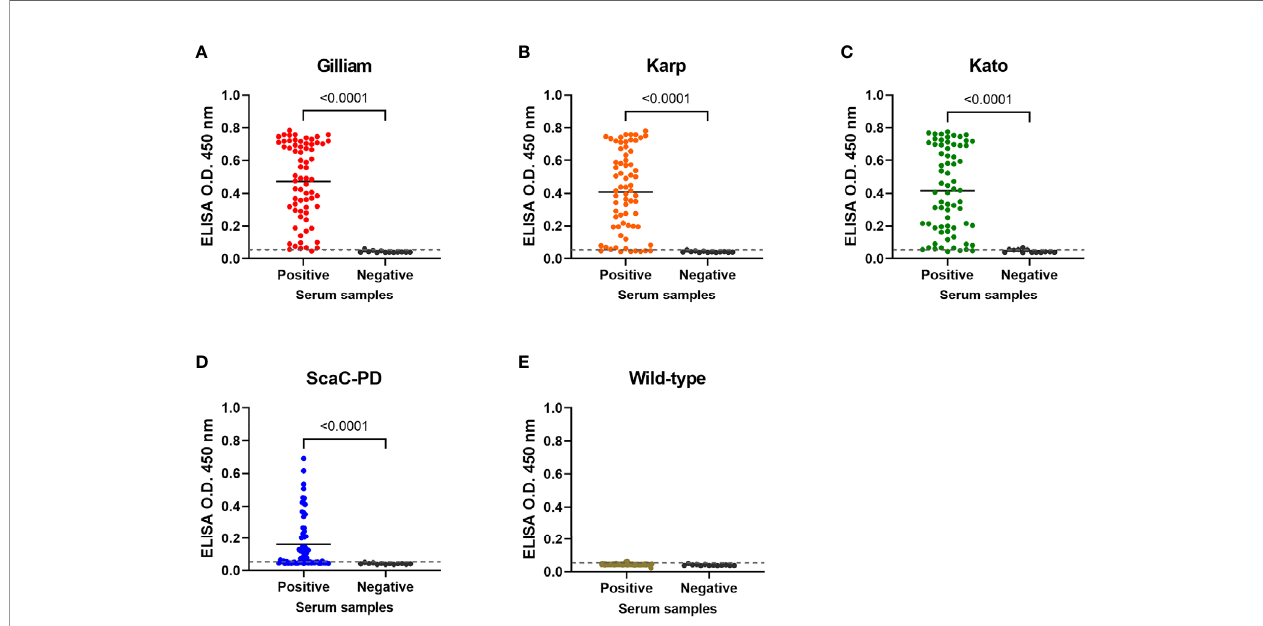
FIGURE 6 | Cell-based ELISA detection of ST in serum samples obtained from fi eld-caught or non-ST rats. Sixty-nine rat sera con fi rmed as having been infected with O. tsutsugamushi by IFA (Positive) and thirteen negative control rat sera (Negative) were subjected to cell-based ELISA using cells displaying Gilliam TSA56 (A) , Karp TSA56 (B) , Kato TSA56 (C) , and ScaC-PD (D) antigens, and cells infected with wild-type baculovirus (E) . Individual data points are shown and the solid line represents the mean value. Dotted line: cutoff value of 0.056 determined as the mean value of negative rat serum reactivities against each of the antigens plus two standard deviations. P -values determined by Welch ’ s t -test are displayed above the